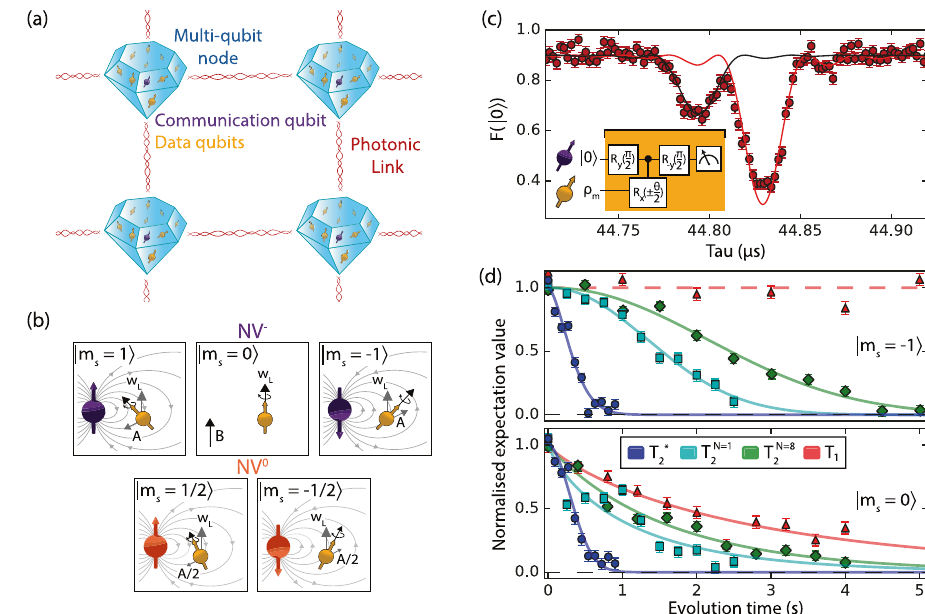
Fig. 1 Architecture for distributed quantum information processing using spins in diamond. a Multi-qubit nodes are formed from electron- spin ‘ communication ’ qubits (purple) which magnetically couple to nuclear-spin ‘ data ’ qubits (yellow), allowing universal control. The coherent spin-photon interface of the communication qubits enables the heralded creation of remote photonic entanglement between nodes. The data qubits enable long-lived storage and processing of quantum information. The network portrayed here forms a unit cell for distributed quantum error correction based on the surface code 3,4,6 . b Electron-nuclear hyper fi ne coupling: nuclear-spin precession at the Larmor frequency around an external magnetic fi eld B is perturbed by the presence of the electron spin. Depending on the NV charge and spin states: NV − (purple), m s = { − 1, 0, + 1}, or NV 0 (orange), m s = { − 1/2, + 1/2}, the precession frequency and axis are modi fi ed. c Dynamical decoupling spectroscopy of the NV centre 43 . The resonance at 44.832 μ s (red) reveals a single 13 C spin with hyper fi ne parameters A ∥ = 2 π ⋅ 80(1) Hz and A ⊥ = 2 π ⋅ 271(4) Hz. The resonance at 44.794 μ s (black) corresponds to the 13 C spin bath. Solid lines correspond to a theoretical model (Supplementary Note 2). d Intrinsic decoherence timescales of the nuclear spin for different electron states. Solid lines are fi ts (see Methods). Dashed lines is a guide to the eye. N denotes the number of spin-echo pulses. All error bars are one standard